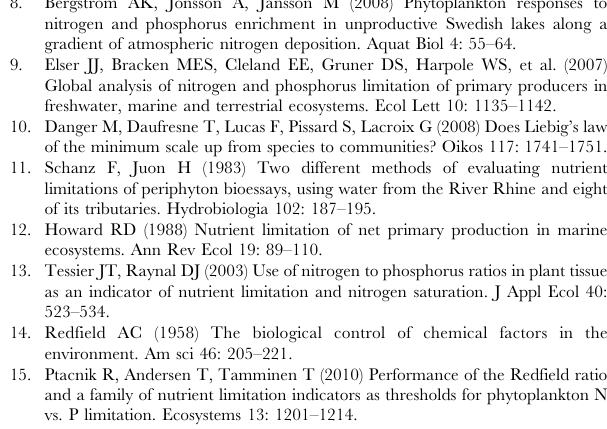
Figure S1 General linear model between OTU cluster- ing resolution and pairwise community dissimilarities (Morisita-Horn distances). (TIF) Figure S2 Proportions of Actinobacteria and Alpha- and Betaproteobacteria in the experiments according to LH- PCR. (TIF) Figure S3 Biovolume of mixotrophic phytoplankton in the experiments. (TIF) Figure S4 Chl a, total N, nitrate, ammonium and total P concentrations in the lake during experimental season.